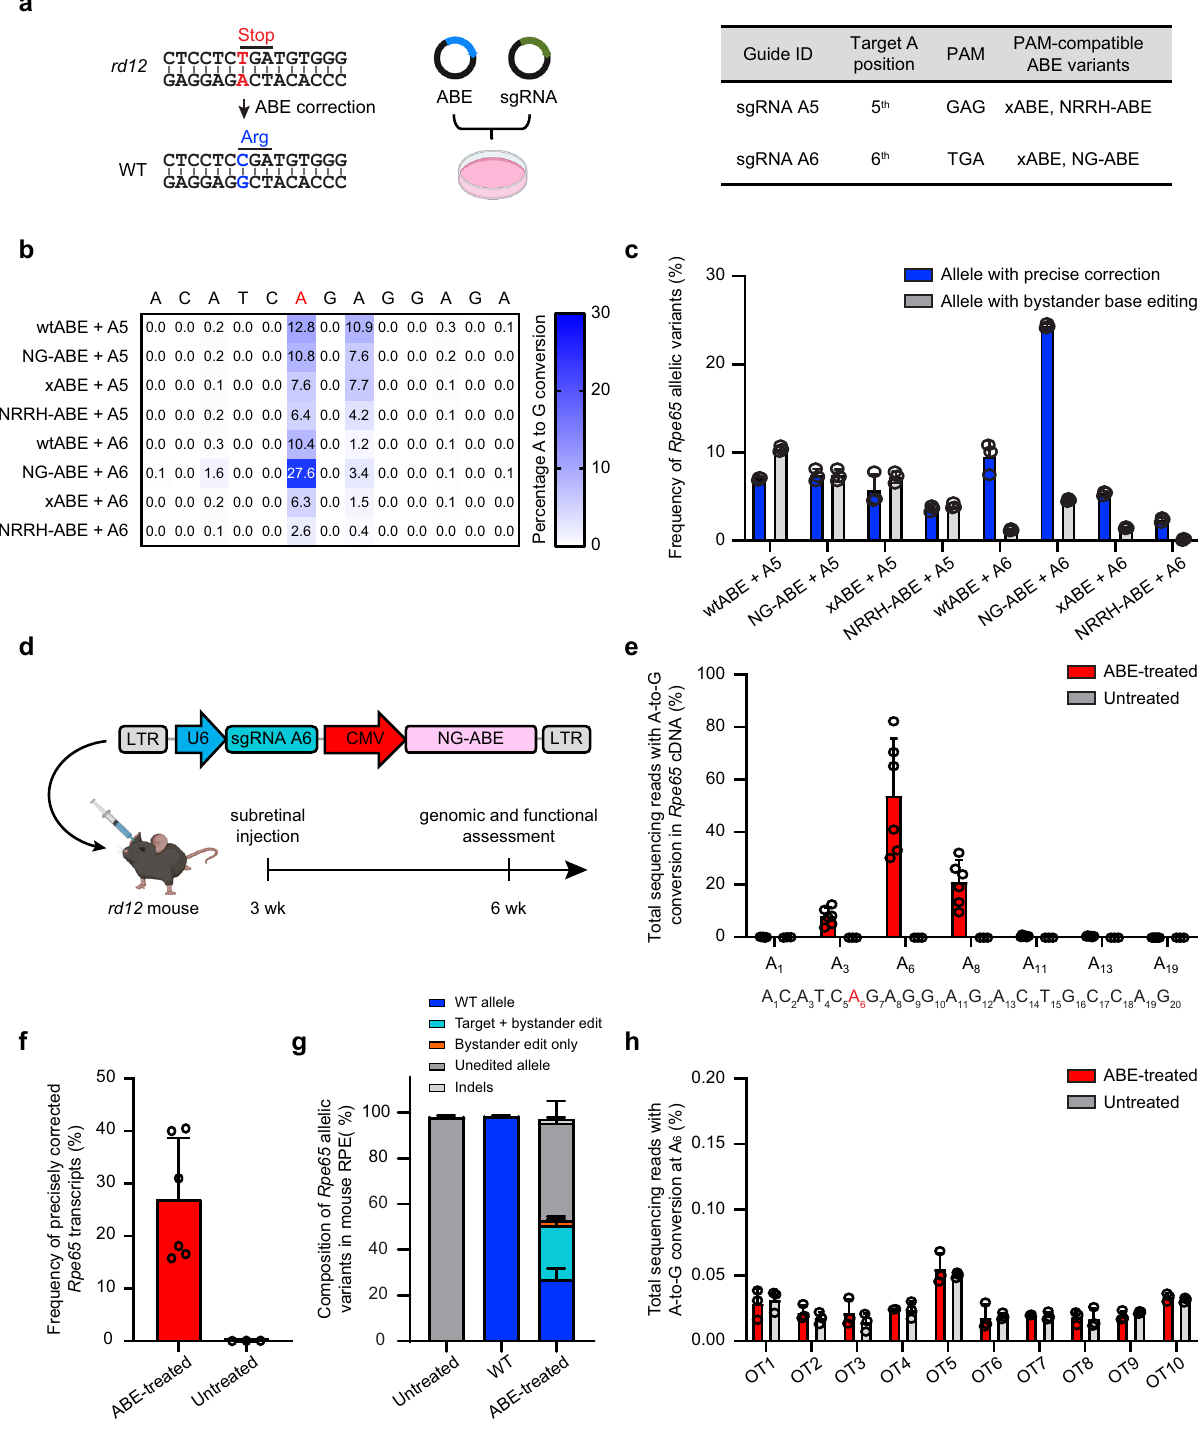
target sites identi fi ed by the CIRCLE-seq 25 , but did not detect off- target editing above the background level of the untreated eyes (Fig. 2h and Supplementary Fig. 2). We further con fi rmed the expression of RPE65 protein via Western blot and the recovery of photoreceptor function by scotopic electroretinography (ERG) after dark adaptation (Supplementary Fig. 3). The treated mice showed scotopic a-wave and b-wave amplitudes of 68% and 74% of WT,